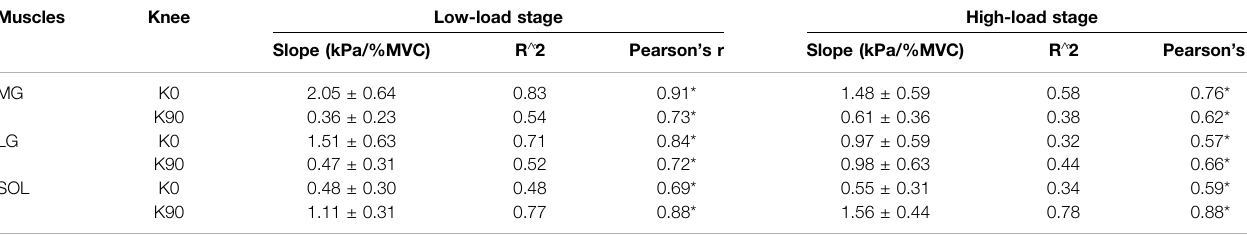
TABLE 2 | Correlation between muscle stiffness and isometric contraction intensity. Muscles Knee Low-load stage